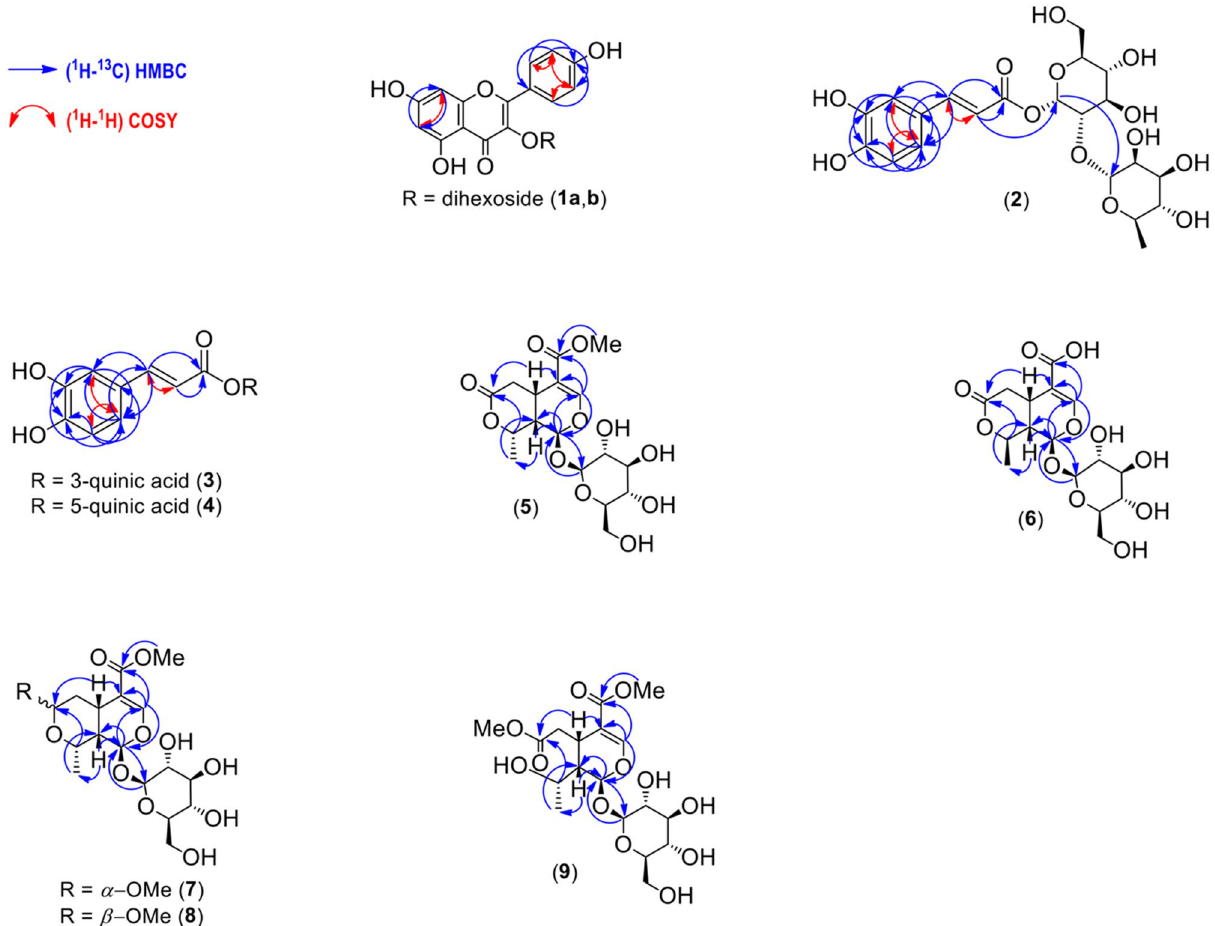
Figure 3. 2D NMR correlations for the major metabolites ( 1 – 9 ) explored in leaf tissue of Citronella gongonha Mart. Metabolites: 1a, b , kaempferol-3- O -dihexoside; 2 , caffeoyl glucoside; 3 , 3- O -caffeoylquinic acid; 4 , 5- O -caffeoylquinic acid; 5 , kingiside; 6 , 8-epi-kingisidic acid; 7 , (7 α )-7- O -methylmorroniside; 8 , (7 β )-7- O -methylmorroniside; 9 , alpigenoside. All of the chemical structures were produced in ChemDraw Ultra v12.0.2.1076 software package (https:// www. cambr idges oft. (δ C 123.0), from H-6 (δ H 6.96, dd, J = 8.2; 2.0 Hz) to C-2 (δ C 115.1), C-3 (δ C 147.0) and C-4 (δ C 149.5), from H-7 (δ H 7.61, d, J = 16.0 Hz) to C-2 (δ C 115.1), C-6 (δ C 123.0) and C-9 (δ C 169.0), from H-8 (δ H 6.27, d, J = 16.0 Hz) to C-1 (δ C 127.1) and C-9 (δ C 169.0). When compared with the MS/MS result, the 2D NMR correlations did not correspond the presence of quinic acid attachment to the caffeoyl segments in 3 or 4 (Table 2). Moreover, the iridoids or secoiridoids are part of naturally occurring monoterpenoids group of compounds that can be major taxonomic markers of plants, especially C. gongonha Mart. In such a class of compounds, this work determined different derivatives such as kingiside ( 5 ), 8-epikingisidic acid ( 6 ), (7 α )-7- O -methylmorroniside ( 7 ), (7 β )-7- O -methylmorroniside ( 8 ) and alpigenoside ( 9 ) respectively. Kingiside ( 5 ) was characterized by LC–MS/MS analysis in the ESI + , representing two molecular ion peaks of m/z 405, indicating probably two epimers ( a , b ) of 5 . By providing a 10 V collision energy, 5a showed the MS 2 fragments of m/z 165, 183, 193, 211, 243, 369 and 387. Although, 5b given the following MS 2 fragments of m/z 165, 193, 211 and 243 suggesting the presence of two epimers of 5 28 (Supplementary Figs. S6–S7, and Table 1). In order to analyzed 1 H HR-MAS NMR data (Fig. 1 and Table 2), metabolite 5 was confirmed on the basis of unique peak of H-1 (δ H 5.65, d, J = 6.1 Hz). This metabolite was moreover characterized through the protons of H-1 (δ H 5.65, d, J = 6.1 Hz), H-3 (δ H 7.51, s), H-5 (δ H 3.22, m), H-6a/H-6b [(δ H 3.01, dd, J = 17.1; 7.6 Hz)/(δ H 2.61, dd, J = 17.1; 6.0 Hz)], H-8 (δ H 4.76 dd J = 6.6; 4.0), H-9 (δ H 2.42, dddd, J = 13.6; 10.2; 6.1; 4.1), the methyl protons of H-10 (δ H 1.52, d, J = 6.8 Hz), methoxy protons of H-12 (δ H 3.71, s), and the glucose proton of H-1 ′ (δ H 4.87, br d). The 2D ( 1 H- 13 C) HSQC NMR (Supplementary Fig. S8) in related metabolite displayed the car- bons at C-1 (δ C 94.4), C-3 (δ C 154.1), C-5 (δ C 28.0), C-6 (δ C 34.0), C-8 (δ C 76.5), C-9 (δ C 40.0), C-10 (δ C 19.3), C-12 (δ C 51.5) and C-1 ′ (δ C 100.0). The main correlations in these compounds through the 2D ( 1 H- 13 C) HMBC NMR (Supplementary Fig. S9, and Fig. 3) were from H-1 (δ H 5.65, d, J = 6.1 Hz) to C-5 (δ C 28.0), C-8 (δ C 76.5) and C-1 ′ (δ H 3.01, dd, J = 17.1; 7.6 Hz)/(δ H 2.61, dd, J = 17.1; 6.0 Hz)] to C-4 (δ C 111.6), C-5 (δ C 28.0), C-7